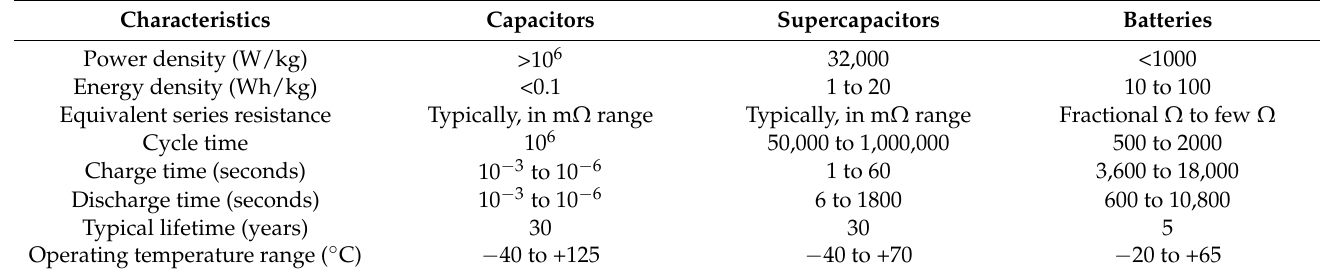
Table 1. Comparison of characteristics of supercapacitors versus batteries and conventional capacitors [7–11].